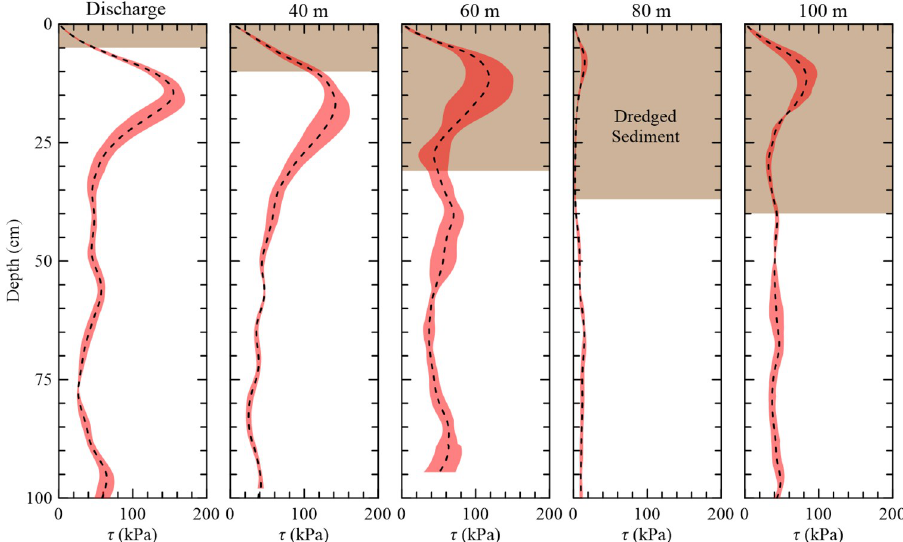
Fig 7. Average shear strength and dredged sediment depths along Transect B moving away from the discharge. Shaded regions represent ± 1 SD.